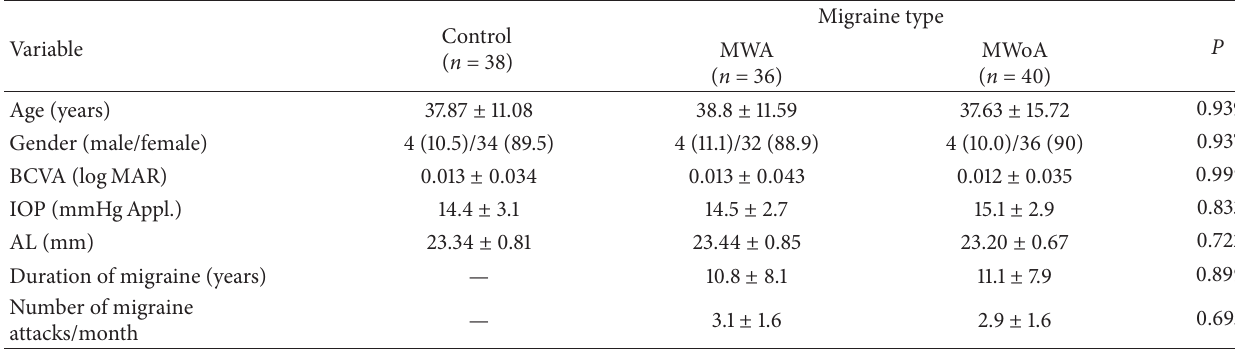
Table 1: Participants’ characteristics.